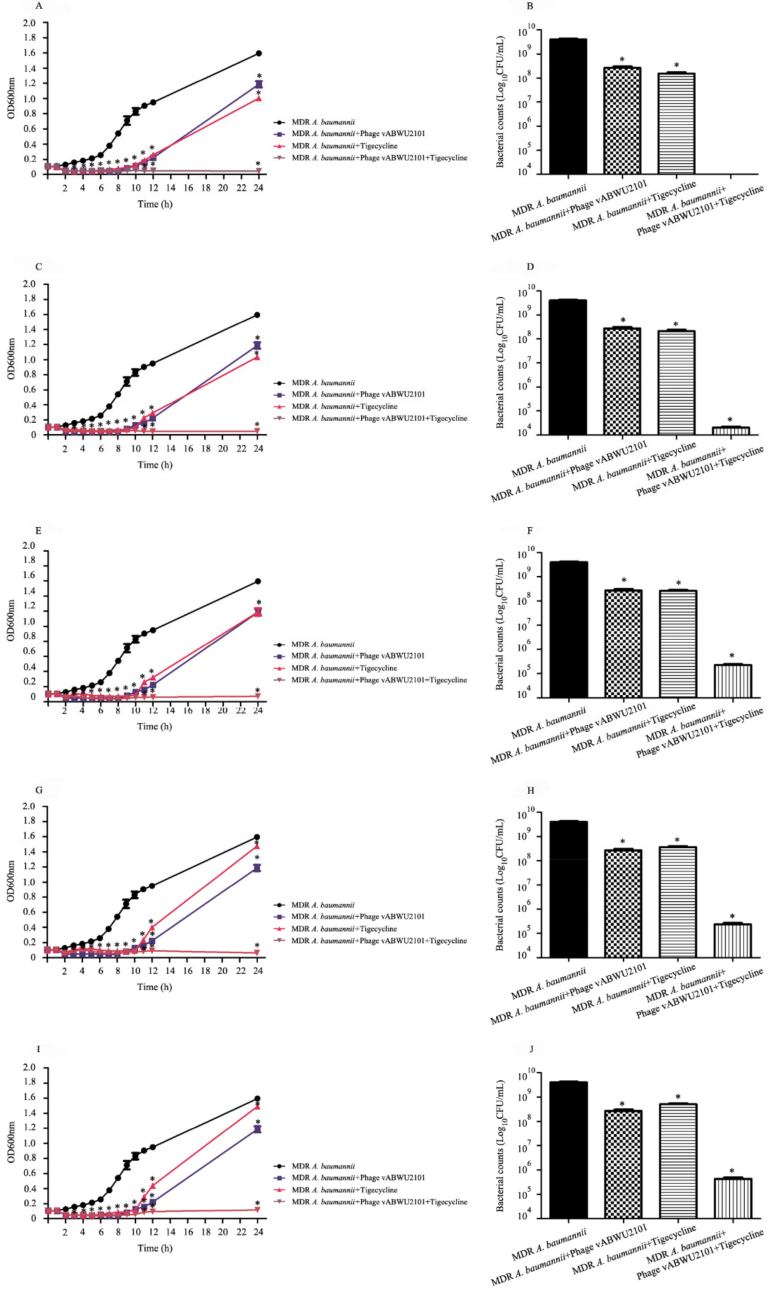
Figure 8. Synergistic antibacterial activity of phage vABWU2101 and tigecycline against MDR A. baumannii . Effect of the combination of phage vABWU2101 and tigecycline at 1/2 × MIC ( A , B ), 1/4 × MIC ( C , D ), 1/8 × MIC ( E , F ), 1/16 × MIC ( G , H ), and 1/32 × MIC ( I , J ) on the MDR A. baumannii growth curve and bacterial cell viability, respectively. The efficacy of a combination of phage vABWU2101 and tigecycline against MDR A. baumannii was evaluated by OD600 measurement every hour for 12 h. At 24 h post incubation, the growth of MDR A. baumannii was determined using the assay. The data show the mean ± SD (* p value <